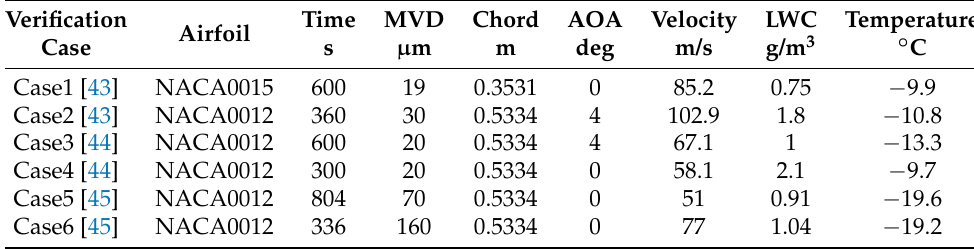
Figure 14. Ice shape characterization metrics. Table 3. Icing conditions for the SSD-case and SLD-case.